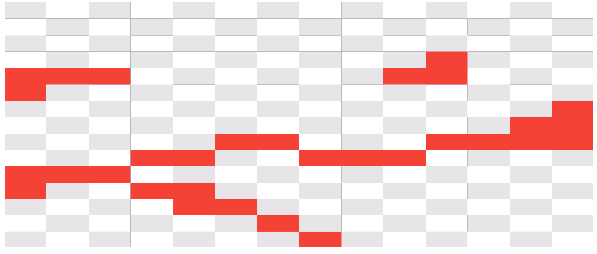
Figure 20. Grid 14 × 15 (manual best case).